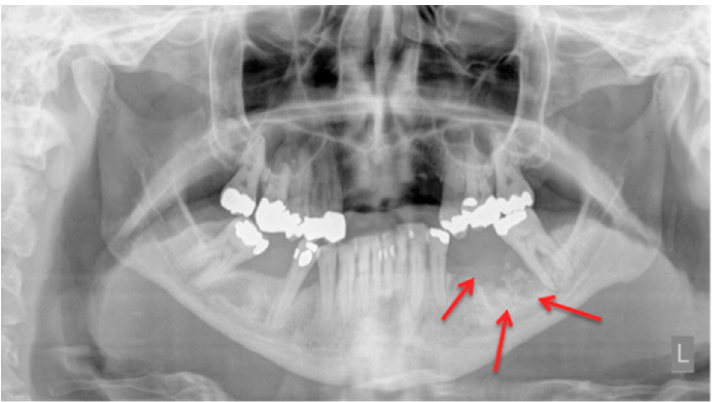
Figure 1. Panoramic radiograph: Patient: 48 years old, female, metastatic breast cancer, zoledronic acid. Red arrows point to the necrotic area. The corresponding magnetic resonance imaging (MRI) images are shown in Figures 6 and 7. American Association of Oral and Maxillofacial Surgeons (AAMOS) staging: stage 2.